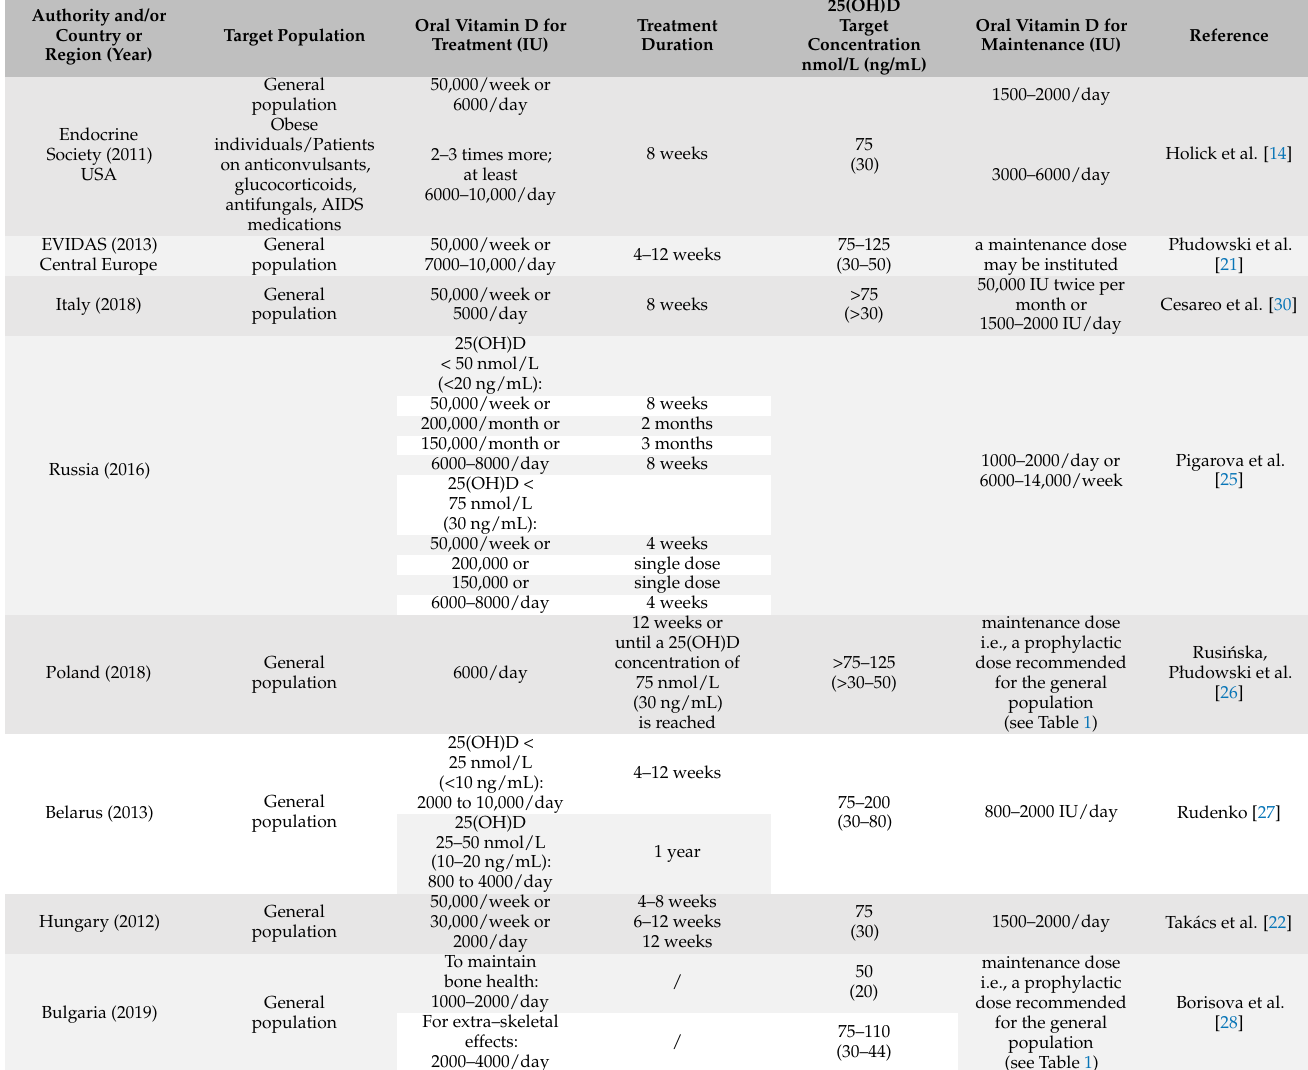
Table 2. Selected guideline recommendations for treatment of vitamin D deficiency in adults with a focus on Central and Eastern European countries, published since